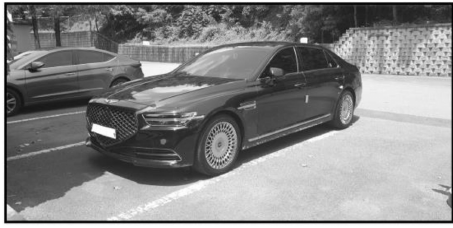
Figure 6. Test vehicle (GENESIS